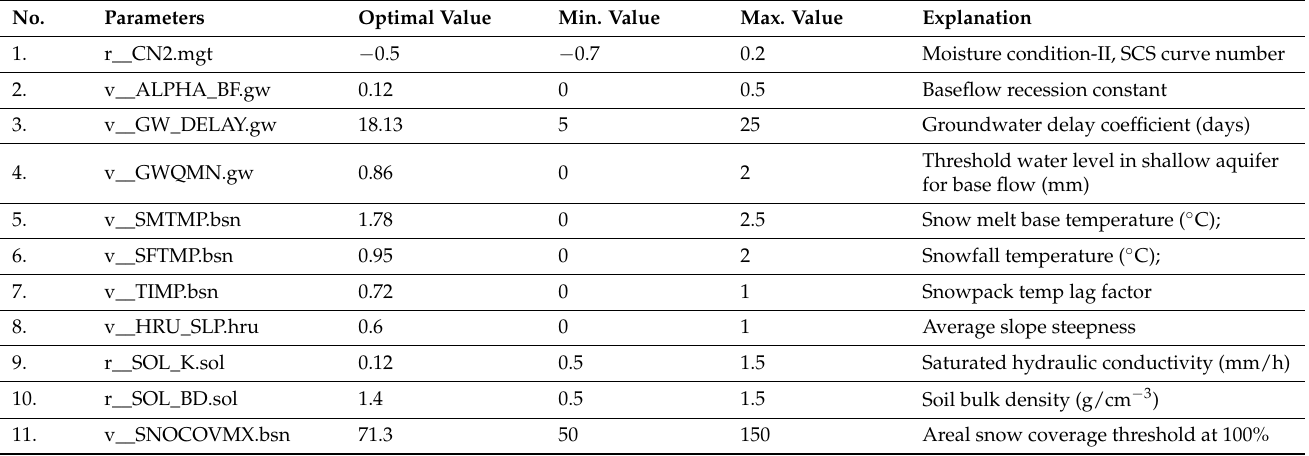
Table A1. Optimal values of sensitive